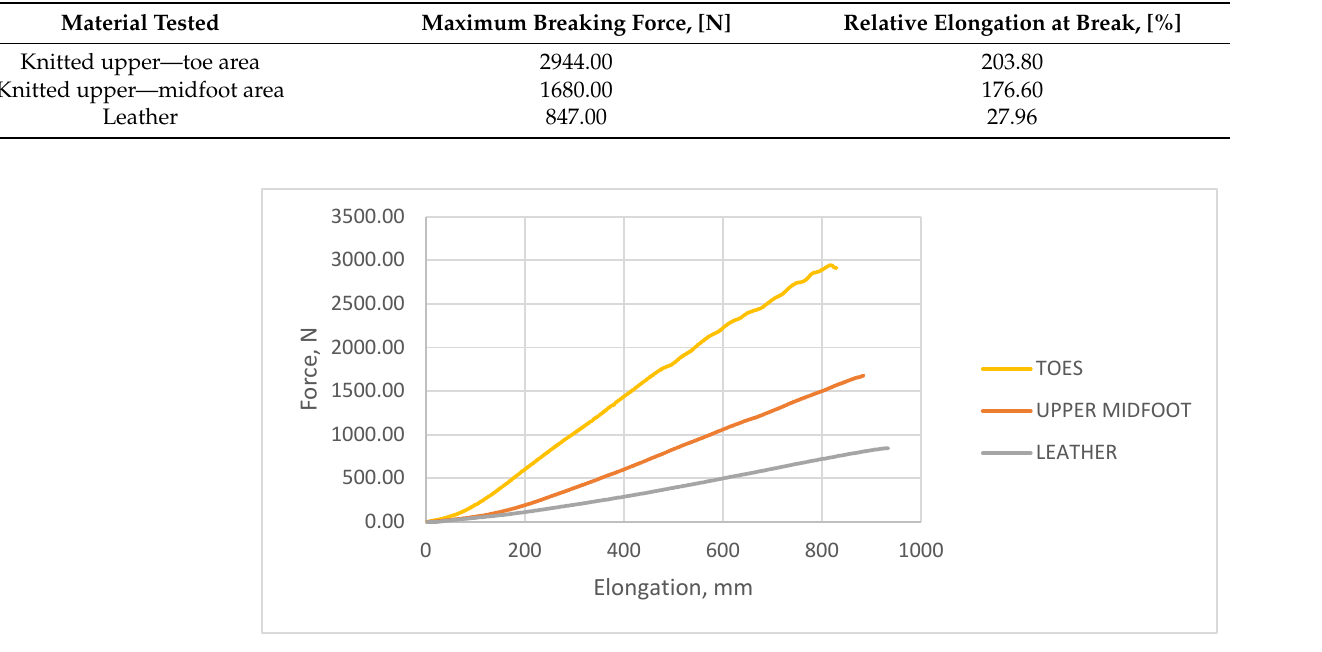
Table 3. A summary of the tensile strength tests conducted according to the EN ISO 13934-1:2002 standard.